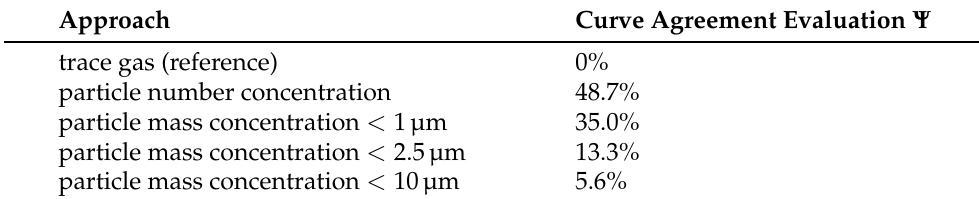
Figure 9. Comparison of quanta concentrations based on particle mass, particle number and trace gas concentrations in a conference room. Table 5. Curve agreement evaluation of different